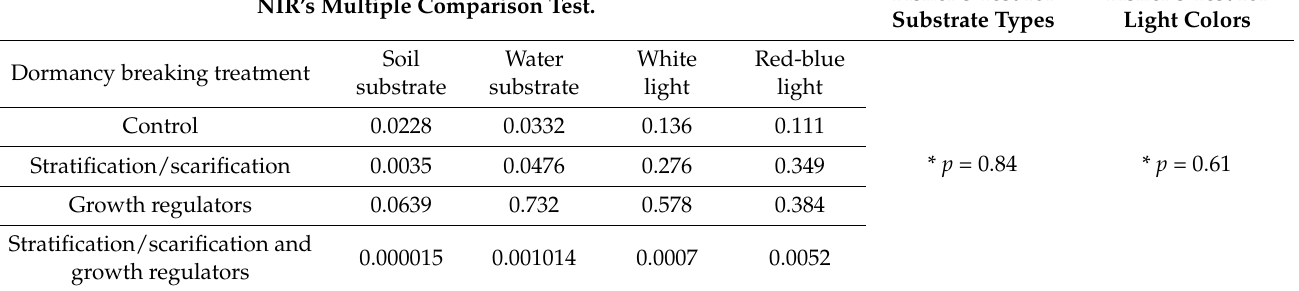
Table 3. Summary of statistical analyses of relationships between selected dormancy breaking methods, substrate types used for germination (soil vs. water), and supplementary light wavelengths (white vs. red-blue). NIR’s multiple comparison test and ANOVA (Fisher’s test). * p —probability value. * Significant differences ( α = 0.05), values greater than the selected significance level are not important.